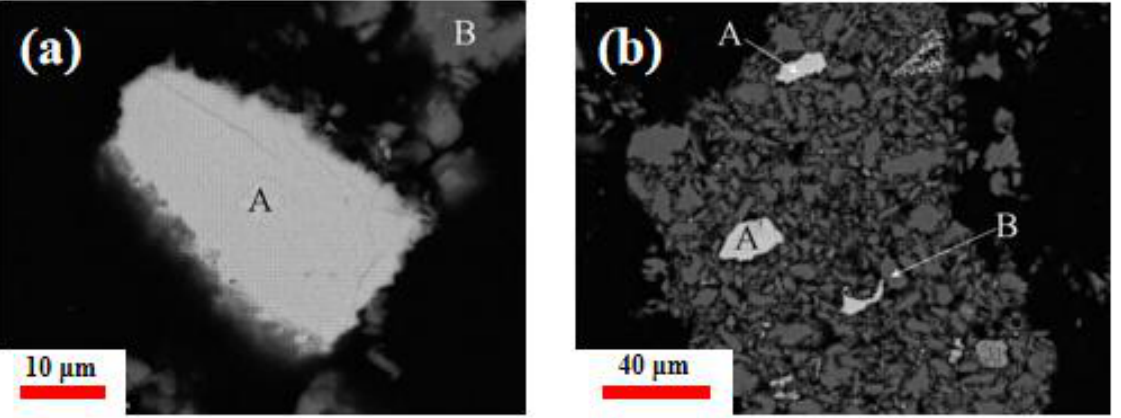
Figure 2. SEM of polished piece of aggregated jarosite residue ( a ) and enlarged area ( b ) (A: Spectrum 1, B: Spectrum 2).